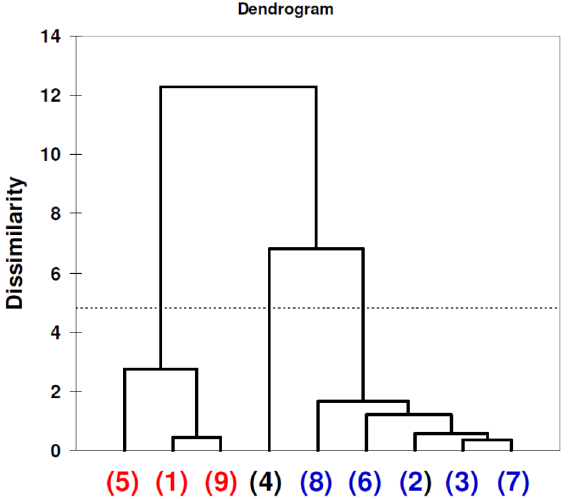
Figure 7. Dendrogram of agglomerative hierarchical cluster analysis involving Ward’s method as the aggregation criterion. The graph represents the clustering of reaction mixtures (BB concentra- tion) with different additives according to experiment time points listed in Table 3 (16 day experi- ment). Object labels are identical to those listed in Figure 6 caption.